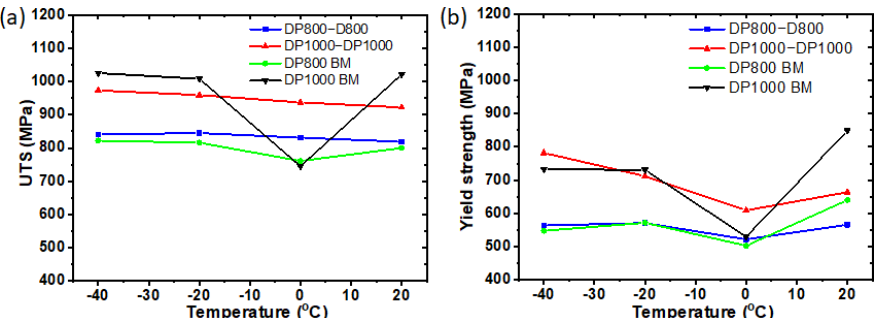
Figure 7. ( a ) UTS and ( b ) YS of base metals and welded DP steels at different deformation temperatures from −40 °C to 20 °C.